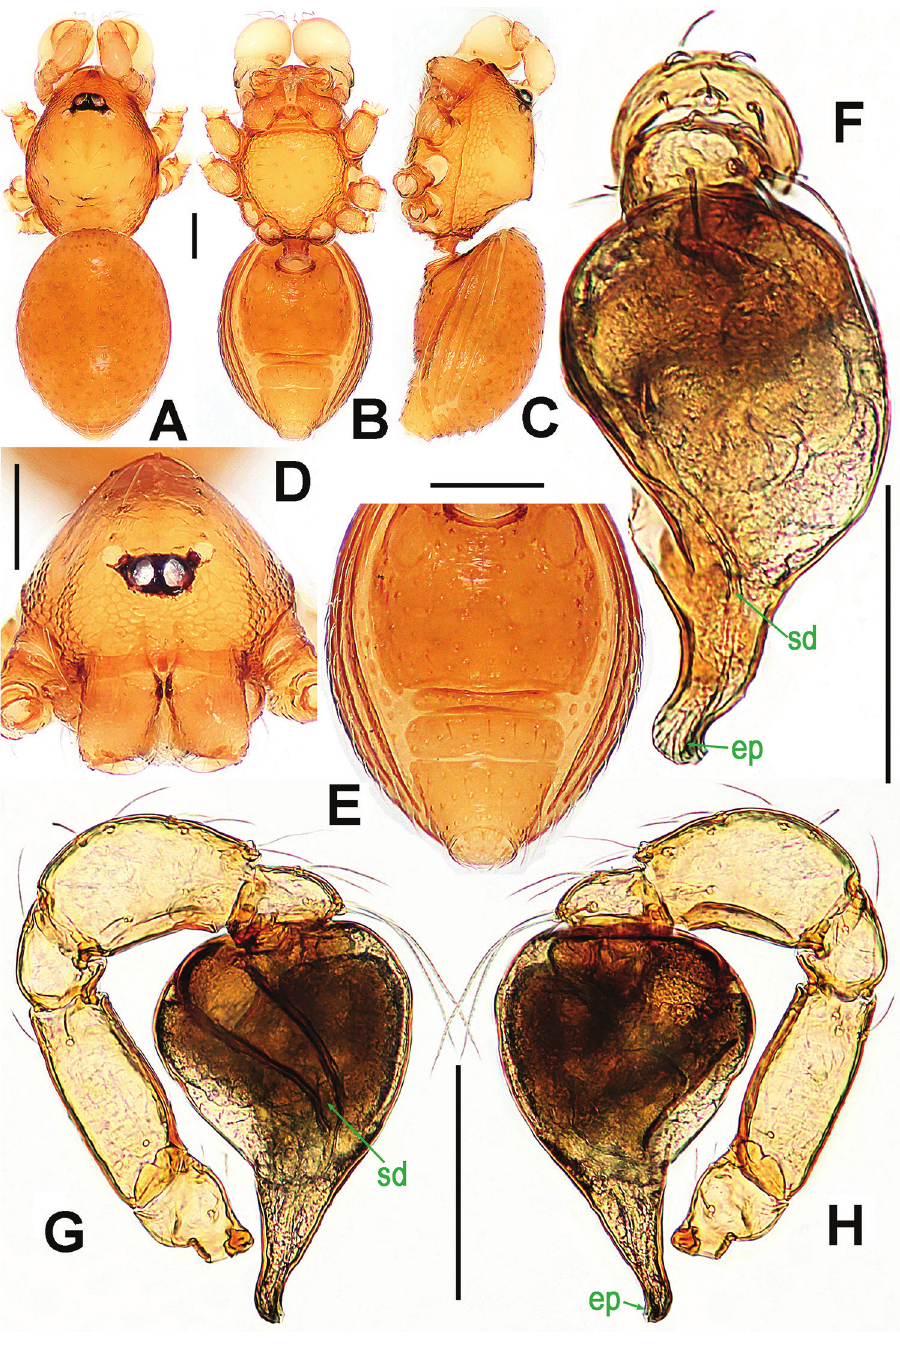
Figure 27. Sulaimania brevis sp. n., male holotype. A–C habitus D prosoma E opisthosoma F–H left palp. A dorsal B, E ventral C lateral D, F anterior G prolateral H retrolateral. Abbreviations: ep = embolic part of apes of palpal organ; sd = spermatic duct. Scale bars: 0.10